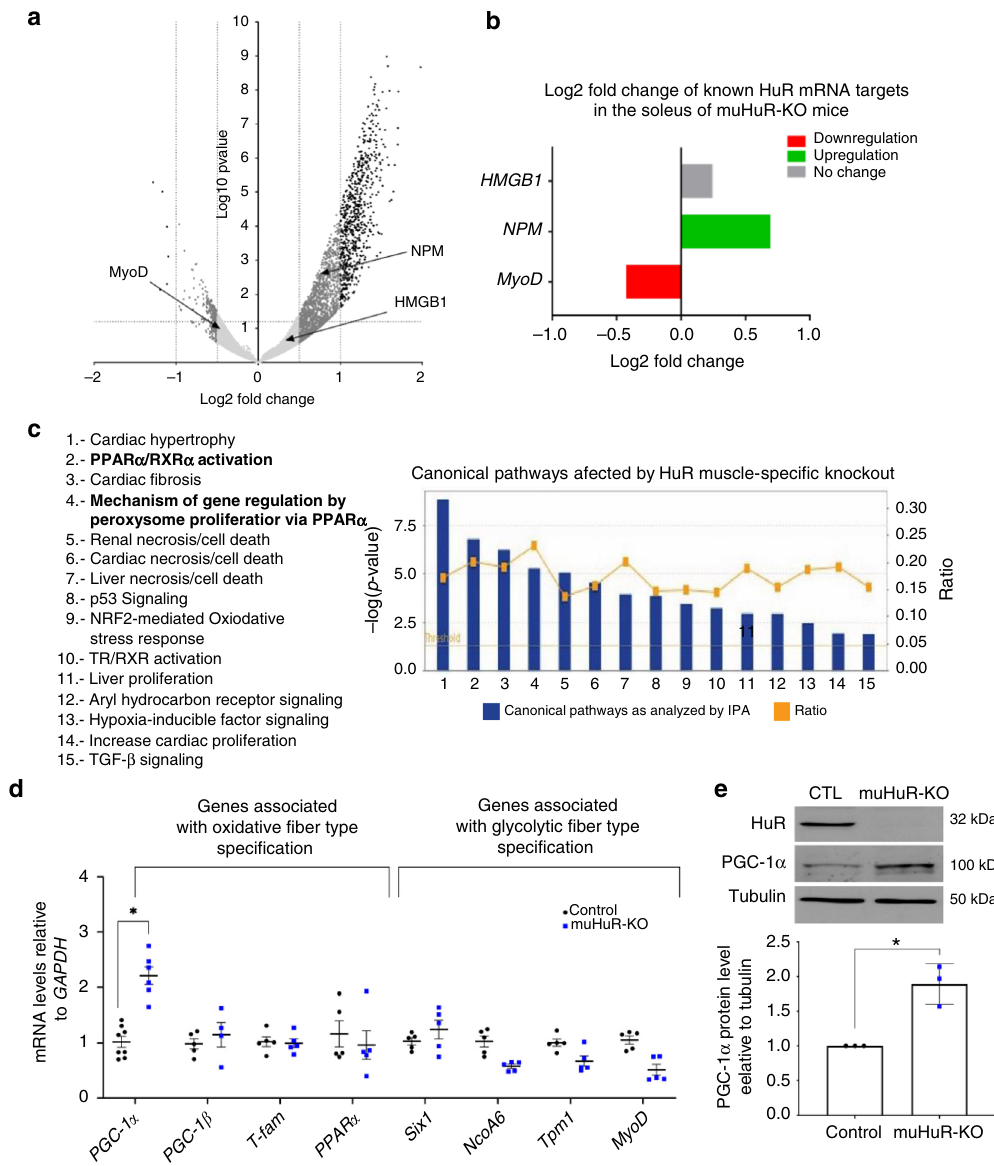
Fig. 5 Increased PGC-1 α expression in muHuR-KO muscle. a Volcano plot showing the log2 fold-difference in mRNA expression in the soleus muscle of control and muHuR-KO mice as assessed by the DESeq2 analysis of the RNA-seq data. Negative values indicate decrease in gene expression while positive values refer to upregulation of gene expression. Dash lanes indicate threshold for statistical signi fi cance ( p = 0.05 for log2FC > 0.5, < 0.5). The location of known HuR mRNA targets, including NPM , HMGB1 , and MyoD are shown. b Comparison of log2 fold change score of the previously identi fi ed HuR mRNA targets NPM , HMGB1 , and MyoD is shown. c Bar graph indicating the signaling pathways affected by the knockout of HuR in soleus muscle as analyzed by Ingenuity Pathway Analysis software (IPA ® ). The x -axis represents the identi fi ed pathways. The y -axis (left) shows the − log10 of the p -value. The ratio ( y - axis, right) represented by the orange points is calculated as follows: numbers of genes in each pathway that meet cutoff criteria, divided by total numbers of genes that are involved in that pathway. The horizontal orange line indicates the threshold above which there is statistical signi fi cance. d Total RNA was isolated from soleus muscles of control and muHuR-KO mice and relative expression level of genes associated with PPAR signaling and/or fi ber-type speci fi cation ( PGC-1 α , PGC-1 β , Tfam, PPAR α , Six1, NCOA6, Tpm1, MyoD ) was assessed by RT-qPCR. Relative mRNA levels were standardized against GAPDH and plotted relatively to the expression in control mice ( n = 5 mice all the genes except for PGC-1 α , were control n = 8 and muHuR-KO n = 6). e Western blot (top panel) and relative quanti fi cation (bottom panel) of PGC-1 α protein levels in soleus muscle from control and muHuR-KO mice using antibodies against PGC-1 α , HuR, or α -tubulin ( n = 3). The results are presented as mean ± S.E.M, * p < 0.05 unpaired t -test. Source Data for panels d , e are provided in the Source Data File and raw data for RNAseq are provided in Supplementary Data